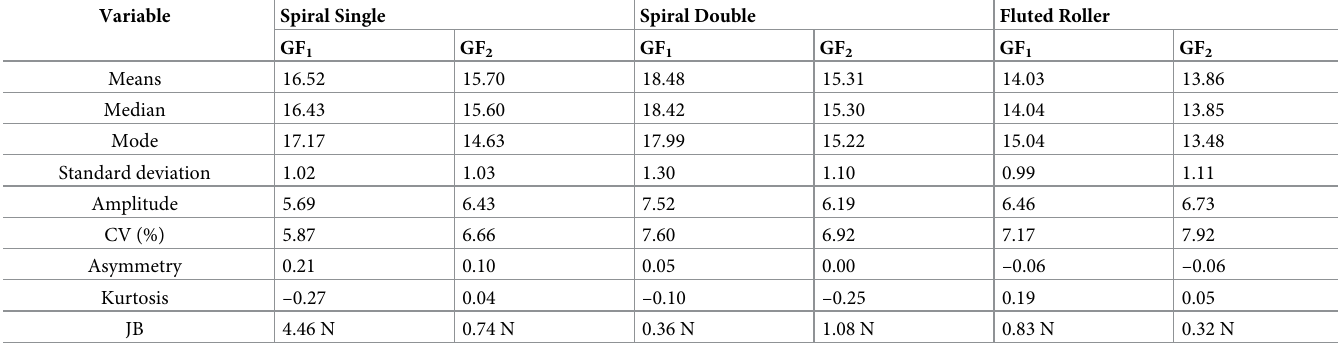
Table 5. Descriptive statistics of the outflow of fertilizers using different fertilizer spreaders at a speed of 1.11 m s -1 .